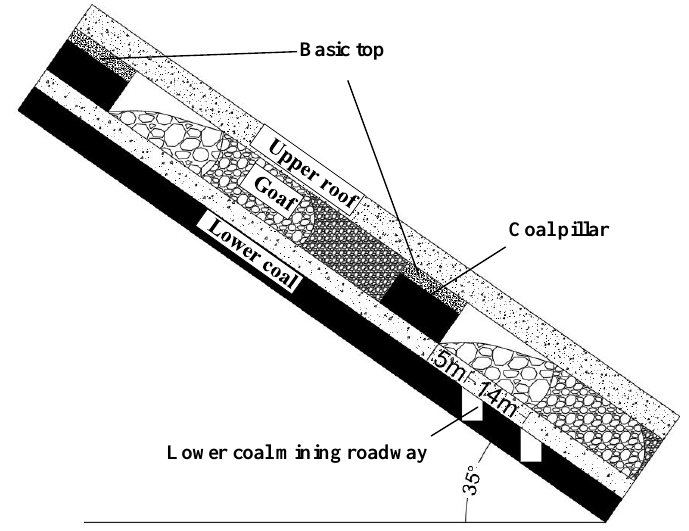
Figure 11. Layout of roadway under residual coal pillar in large-dip seam.